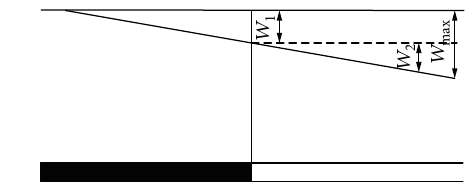
Figure 2: Mining stress distribution.